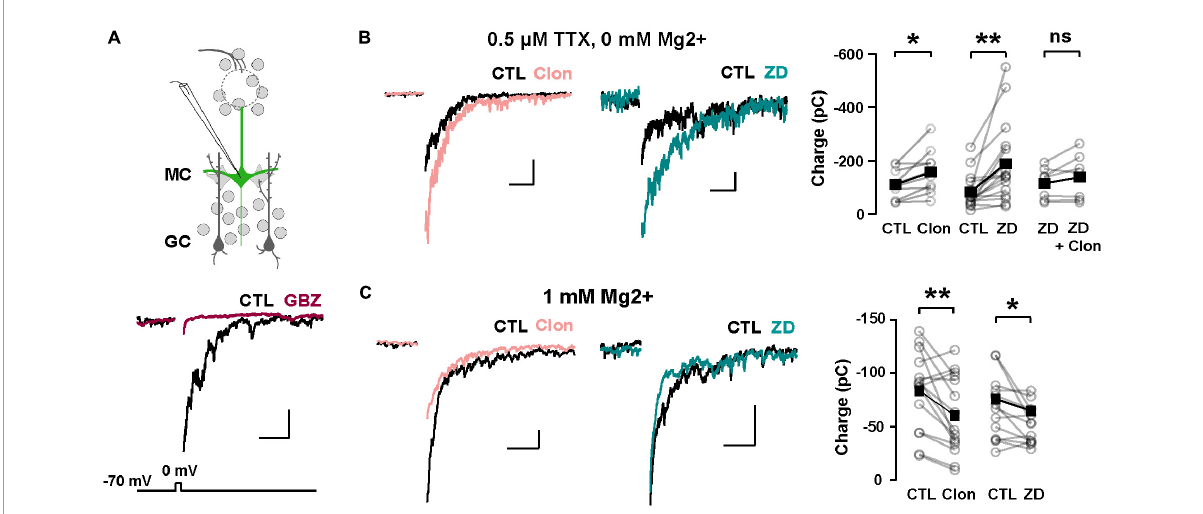
FIGURE5 α 2 -AR modulation of I h on GC dendritic excitability and recurrent inhibition. (A) Top: recording scheme for eliciting reciprocal dendritic inhibition. We recorded recurrent inhibition elicited by a depolarizing voltage step in MCs in slices from the Thy1-ChR2 mouse. Sample traces show dendrodendritic inhibition, in which MCs were depolarized from –70 to 0 mV to recruit recurrent inhibition. Bottom: the current is abolished by the GABA A antagonist gabazine (GBZ, 10 µ M). (B) Representative averaged traces of recurrent inhibition obtained in TTX (0.5 µ M) and Mg 2 + -free ACSF, and summary plots. Activation of α 2 -ARs by Clon (10 µ M; pink, n = 10 cells, * p = 0.01) and blockade of I h with ZD7288 (ZD, 10 µ M; teal, n = 16 cells, ** p = 0.003) increased the recruited inhibition. Clon failed to increase the recruited inhibition with the pre-application of ZD ( n = 7 cells, p = 0.14). The calibration is 100 pA and 500 ms. (C) In physiological ACSF (1 mM Mg 2 + and no TTX), α 2 -AR activation by Clon and I h blockade by ZD failed to increase recurrent inhibition in MCs. Instead, a small reduction is observed in the presence of ZD (Clon, n = 15, ** p = 0.006; ZD, n = 13 cells, * p = 0.03). The calibration is 50 pA, 200